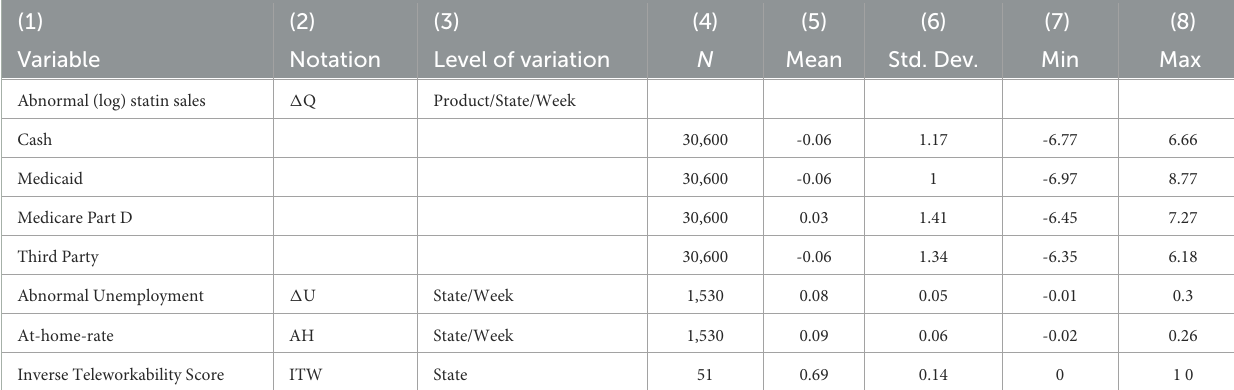
TABLE 3 Descriptive statistics of main